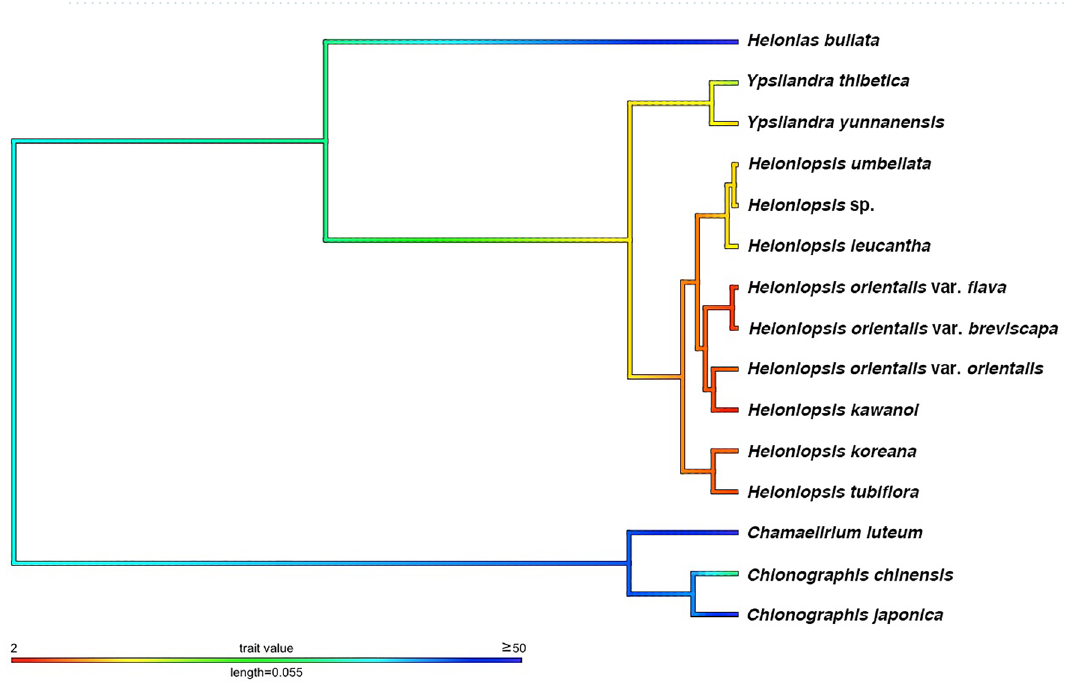
Figure 6. Evolution of number of flowers per inflorescence of Heloniadeae. Trait value represent flower number in an